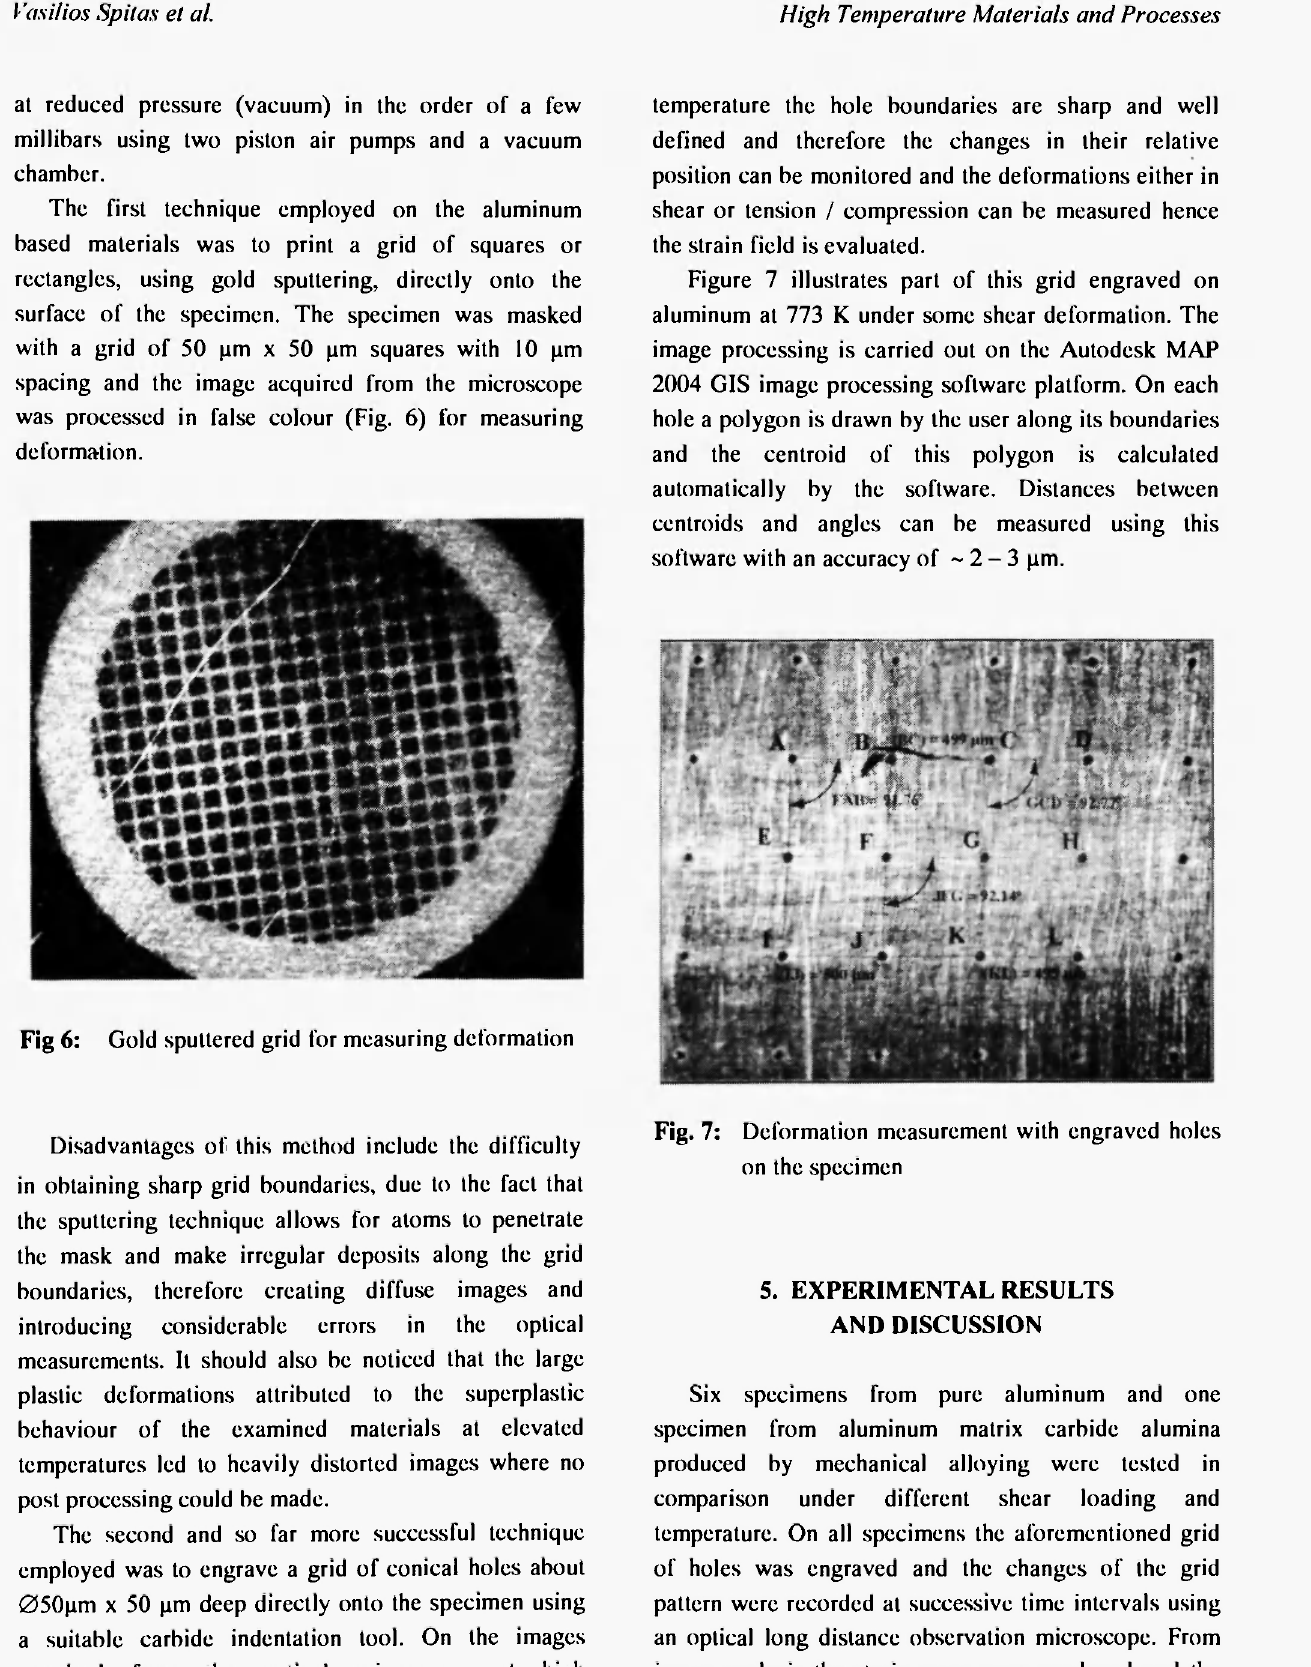
Gold sputtered grid for measuring deformation